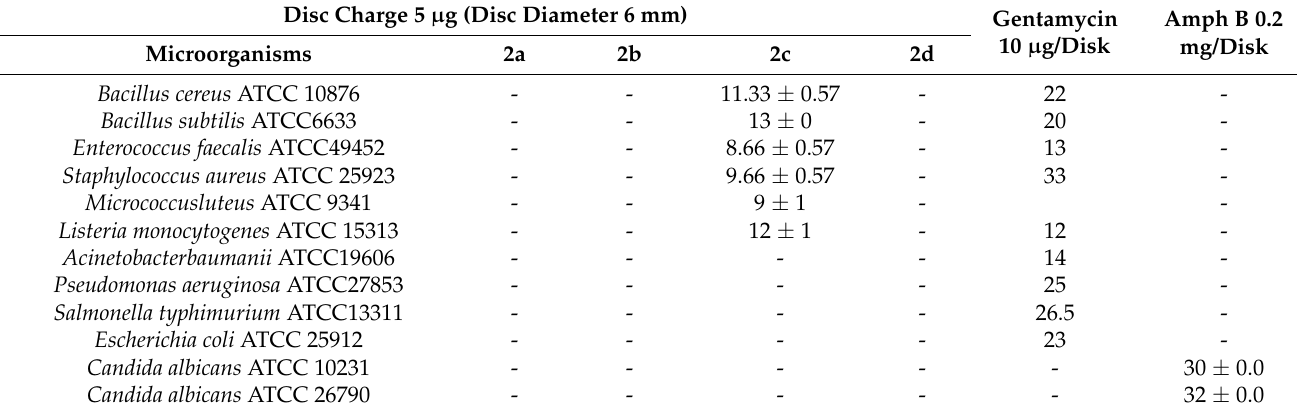
Table 4. Results of theantimicrobial assayusing the disk diffusion method.